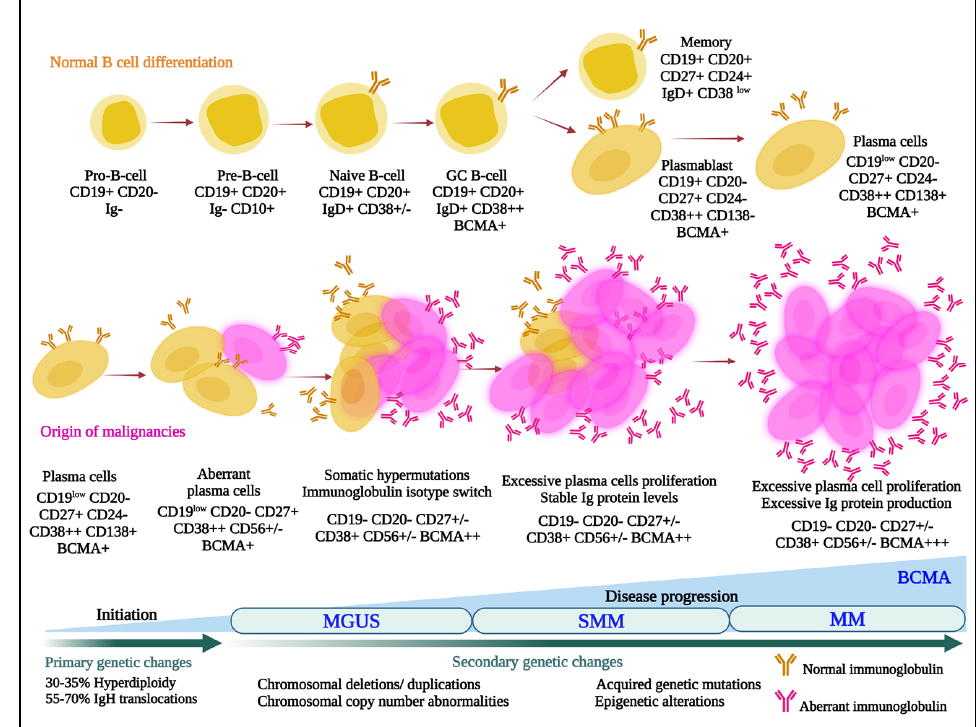
Figure 1. Normal (upper panel) and aberrant (lower panel) B-cell differentiation processes are outlined, and cells are annotated with some of the lineage-specific surface markers that may be targets for antibody–drug conjugates. MGUS, monoclonal gammopathy of undetermined significance; SMM, smoldering multiple myeloma; MM, multiple myeloma; BCMA, B-cell maturation antigen; IgH, immunoglobulin heavy locus.